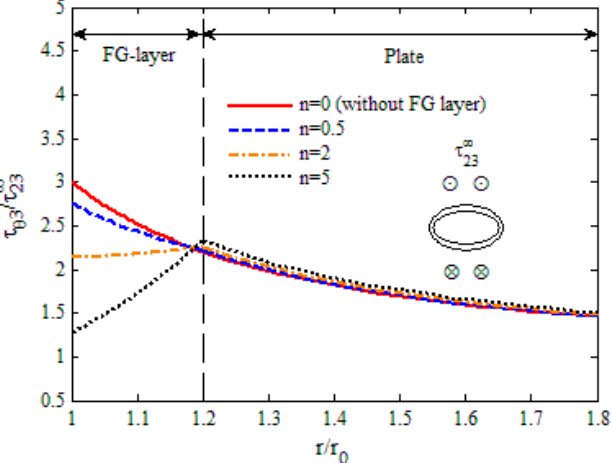
Figure 9. The variation in shear stress τ θ 3 along the normal direction of the hole (ellipse, δ = 0 ◦ ).